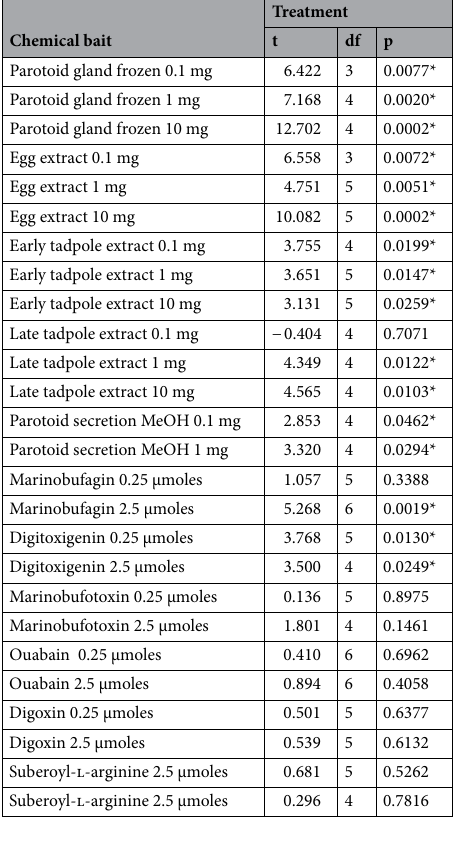
Table 1. Logistic regression results for attraction (trap preference: chemical vs control) by toad tadpoles. Model structure had main effects of Treatment and Time, with trap nested within pool and responding tadpole clutch as random effects. The main effect of Time was p < 0.0001 for all chemicals. *p < 0.05 for Treatment